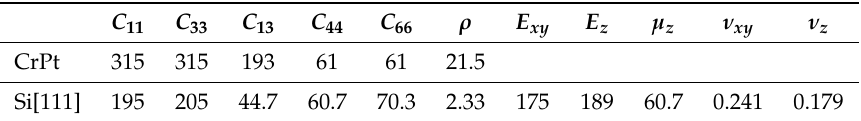
Table 1. Unmodified input material constants for the coating CrPt and substrate Si[111]. Elastic